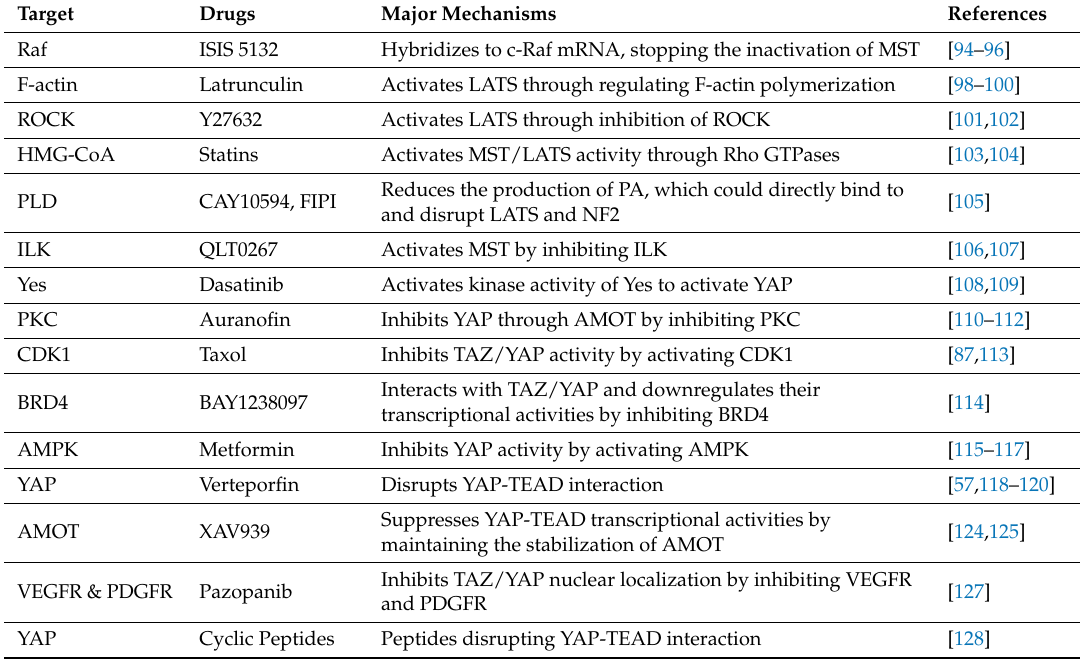
Table 2. Agents targeting the Hippo pathway in breast